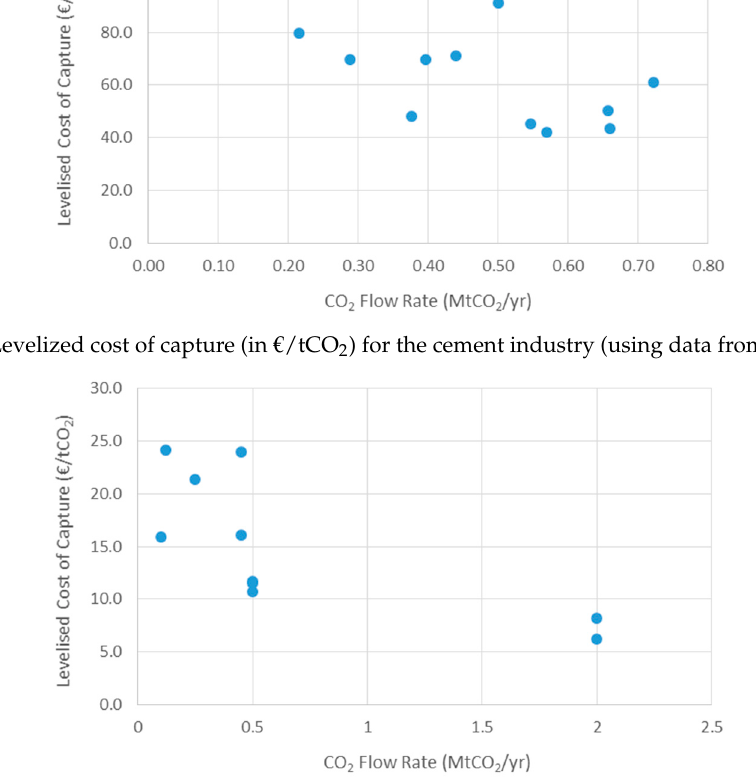
Figure 3. Levelized cost of capture (in €/tCO 2 ) for the high purity sources, using data from [62,63].